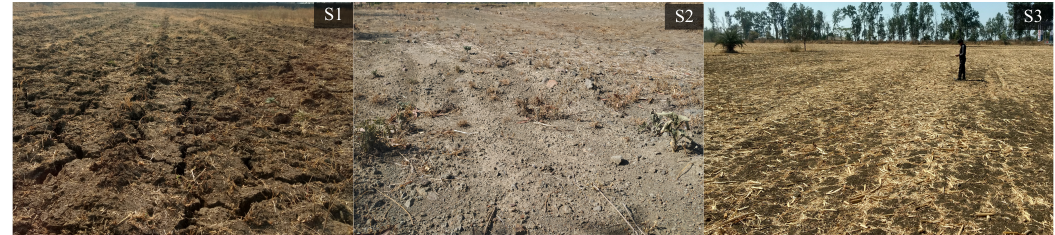
Figure A1. Soil samples used from three different fields for the calibration of MLT-3 theta probe. Samples from S1 and S3 corresponds to agricultural lands composed of black cotton soil and rich in organic matters. S2 consists of black soil with granules rubble (about 20–25%) formed due to the subsequent weathering of Deccan basalt.